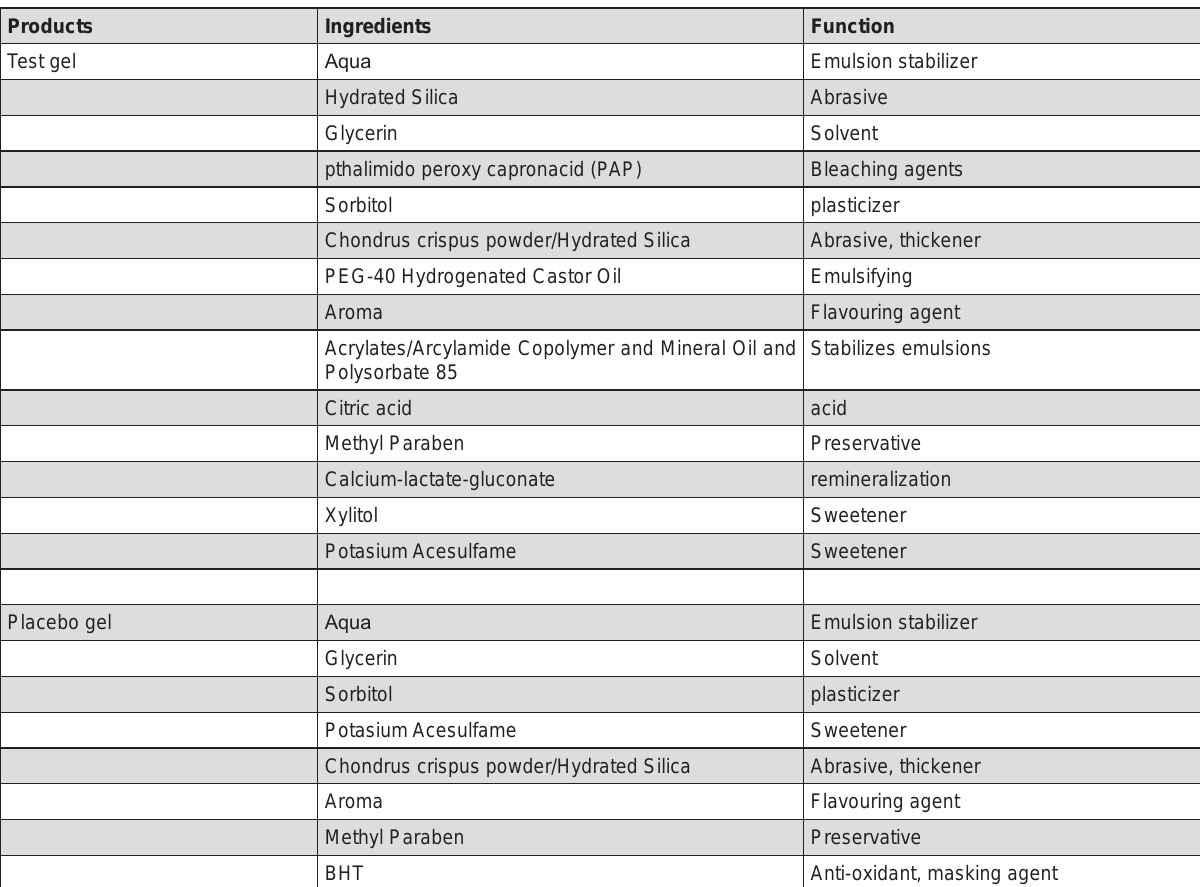
Figure 1- Ingredients of the test and placebo bleaching